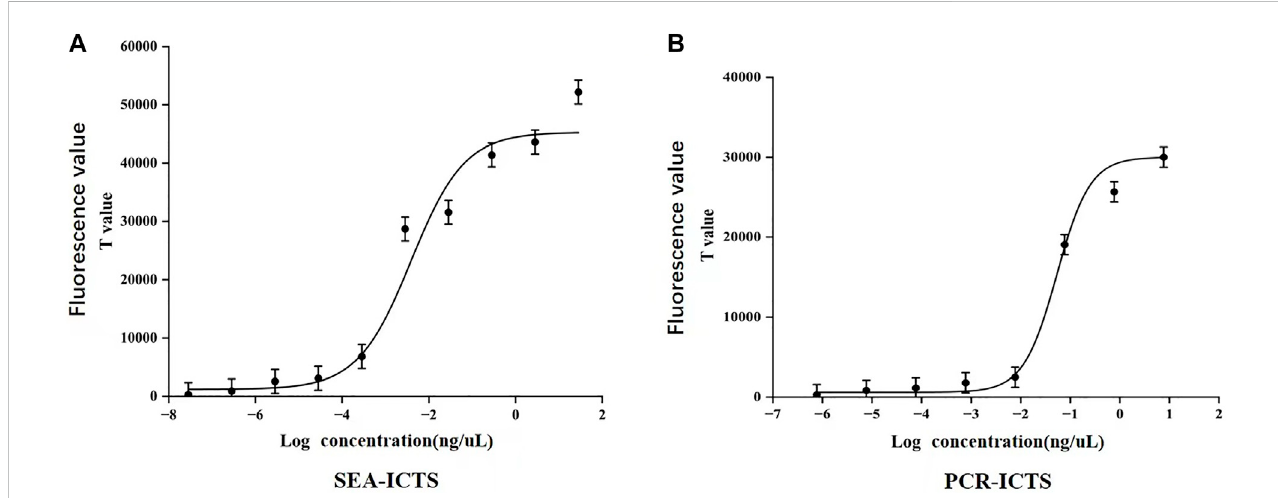
FIGURE 7 Sensitivity detection of Klebsiella pneumoniae . (A,B) , The correlation curves were established with the logarithmic value of DNA concentration as the abscissa and the signal value (T value) of ICTS as the ordinate. Each valuewas derived from three independent experiments, and the error bars mean standard